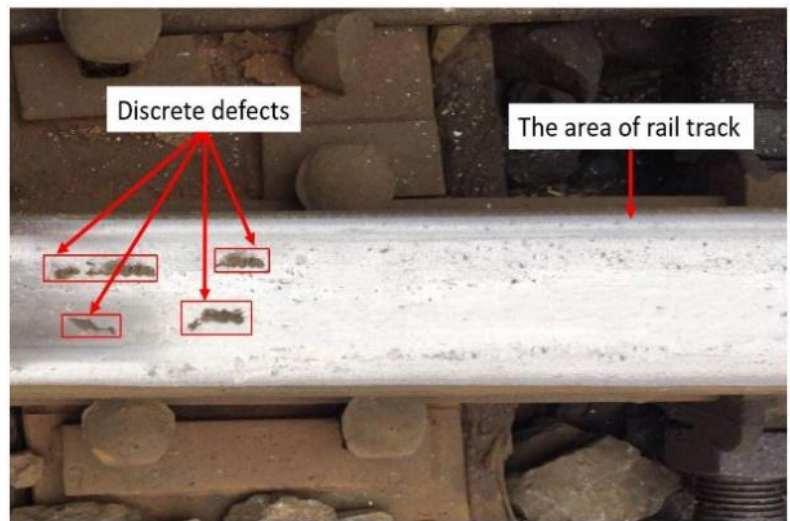
Figure 1. The discrete defects on the rail surface.